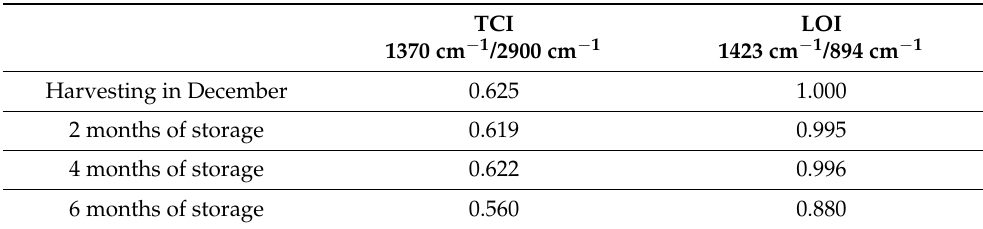
Table 2. Total Crystallinity Index and Lateral Order Index of cellulose after harvesting in December and 2, 4, 6 months of